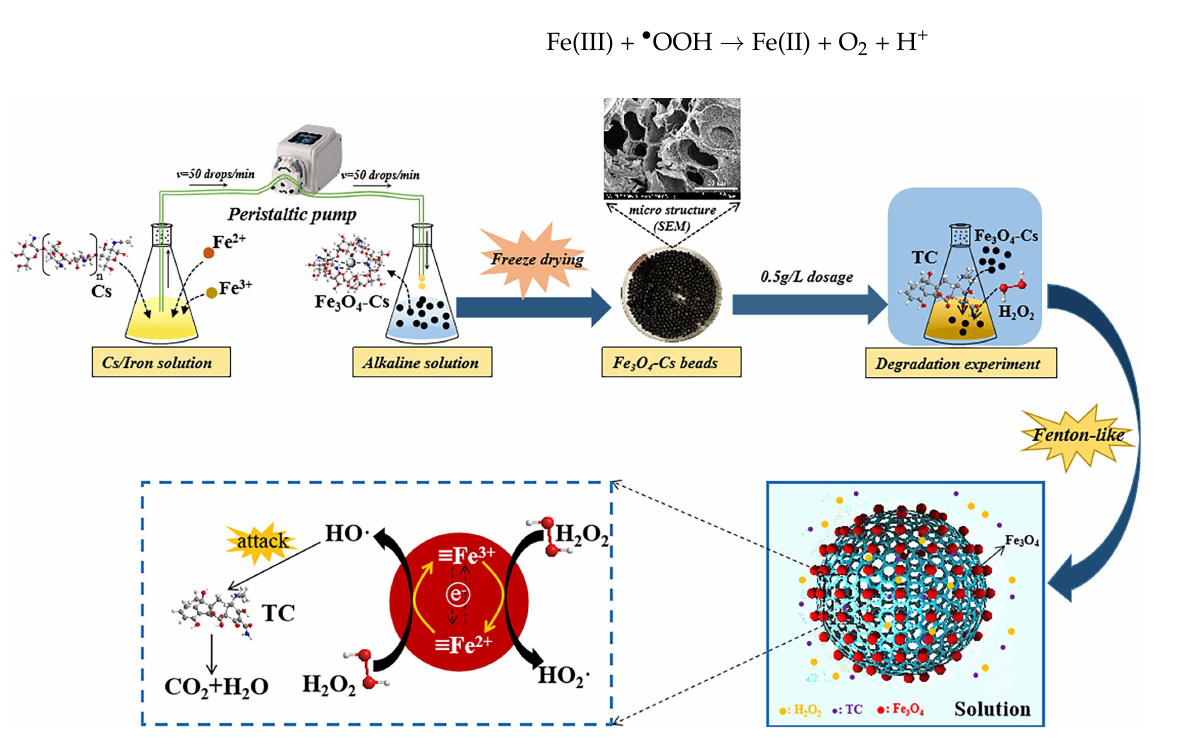
Figure 4. Schematic illustration showing the main steps of H 2 O 2 activation and TC degradation in the Fe 3 O 4 -Cs/H 2 O 2 Fenton-like system [82], Copyright 2020 Elsevier.